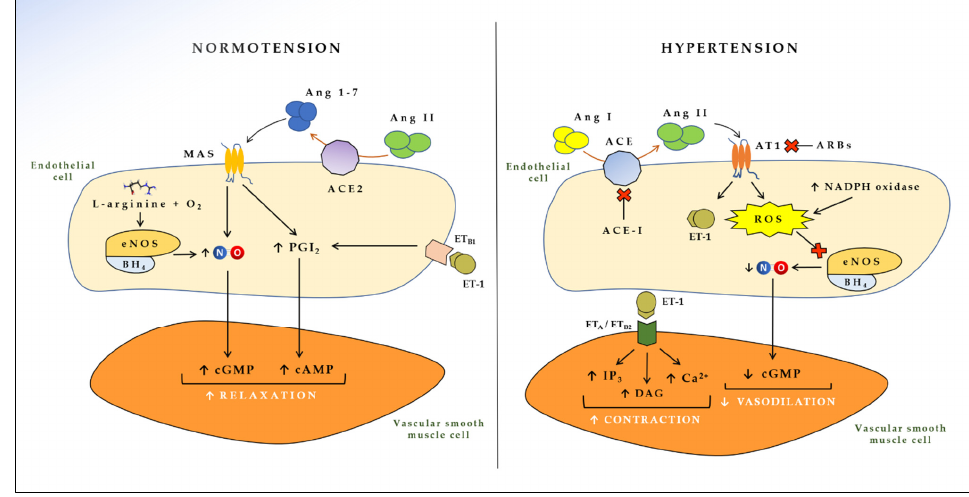
Figure 1. Effects of endothelial-derived vasoactive mediators in the cross-talk between endothelial and vascular smooth muscle cells. ACE: angiotensin converting enzyme; ACE2: angiotensin